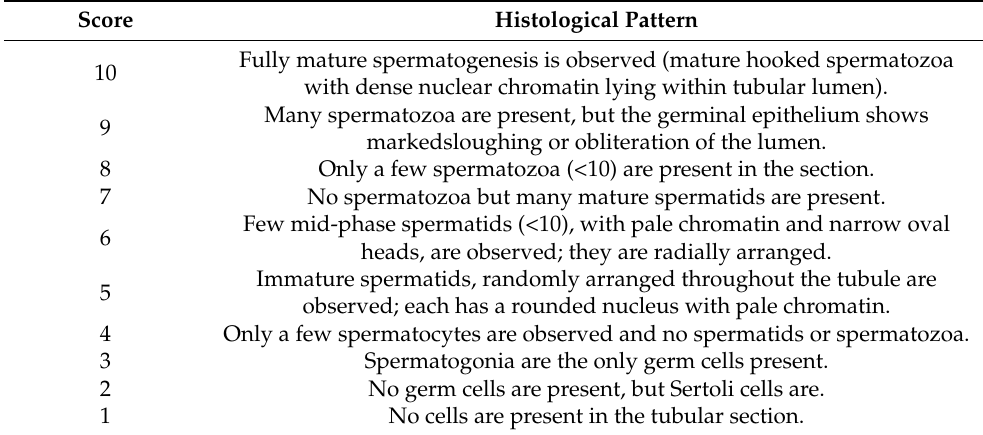
Table 1. Johnsen’s score for squirrel monkeys ( Saimiri collinsi ). Adapted from Johnsen (1970) and Manabe, Takeshima, and Akaza